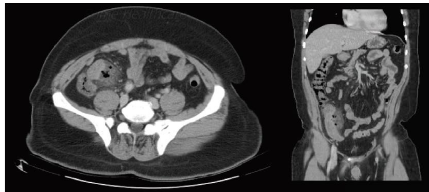
Figure 1: Computed tomography of the abdomen demonstrating mural thickening on the descending and ascending colon with adjacent fatty stranding.